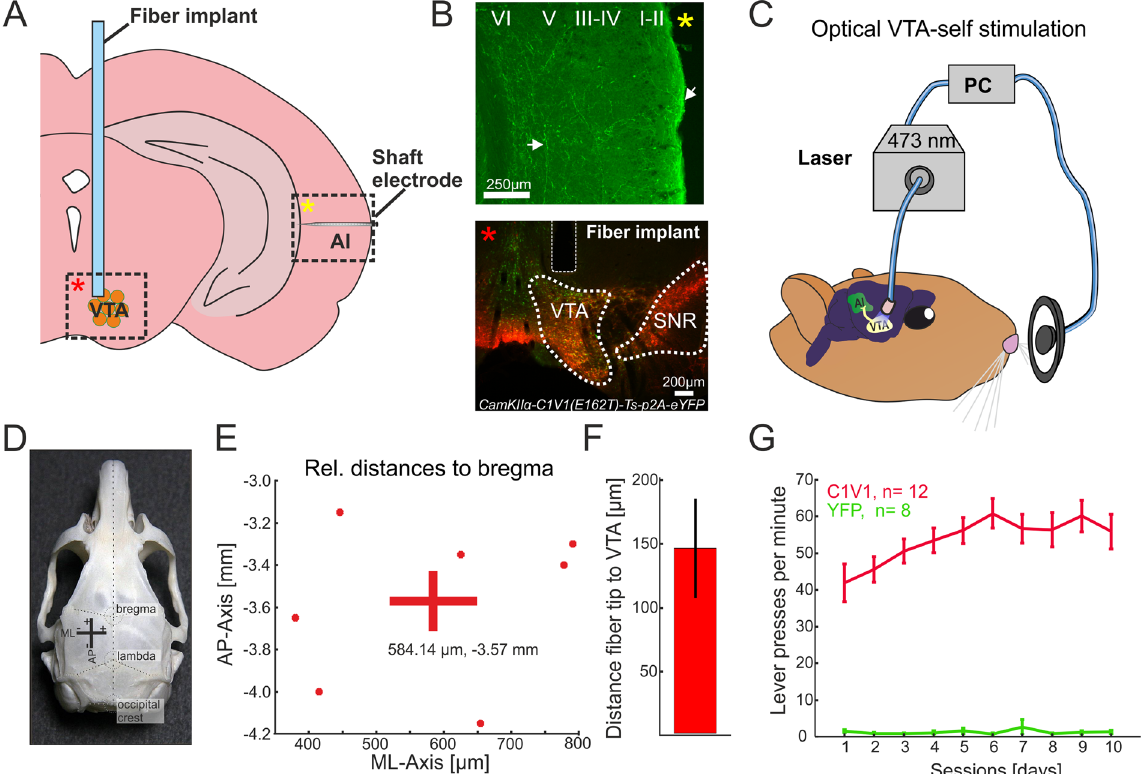
Figure 1. Anatomical validation of fiber position relative to target side and optogenetic intracranial self- stimulation ( A ) Schematic overview of fiber implant position for optogenetic stimulation of the VTA, and the ipsilateral AI recording side. Dashed boxes indicate representative regions of interest shown in B) identified by yellow and red asterisks. ( B ) Top, YFP expression in the temporal cortex covering the region of AI after virus transduction of the VTA indicates fiber terminals from the VTA targeting mainly upper layers and collaterals in deeper layers (white arrows). YFP expression was detectable in multiple regions of the neocortex (not shown). Bottom, co-fluorescence of YFP (AAV-CamKII α -C1V1 (E162T)-p2A-eYFP) and TH-immunostaining (Alexa Fluor 546). Area of co-fluorescence is indicative of overlapping neuronal populations expressing the virus and TH mainly found in the VTA, and not the substantia nigra 24 . Scale bars indicate 250 and 200 µ m, respectively. ( C ) Schematic representation of optogenetic intracranial self-stimulation: While nose-poking the lever, animals induce a light flash towards the VTA resulting in extensive self-stimulating behavior 25 . ( D ) Gerbil skull with prominent landmarks (bregma, lambda and occipital crest) for anatomical reference modified from Radtke-Schuller et al . 2016. For experiments, bregma has been used for reference of medio-lateral (ML) and anterior-posterior (AP) position of the VTA. ( E ) Estimated actual AP/ML coordinates with mean coordinates (AP: − 3.57 mm; ML: 584.14 µ m) relative to bregma of the C1V1group (n = 7) as estimated with the gerbil brain atlas 84 . ( F ) Fiber distance (mean ± SEM) towards area of co-fluorescence (146.8 ± 38.9 µ m; n = 7). Compare with bottom picture of B). ( G ) Averaged lever pressing rates (lever presses/min) of the C1V1 (n = 12) and YFP (n = 8) groups over 10 days. A representative video of a C1V1 animal is accessible as Movie (See Video